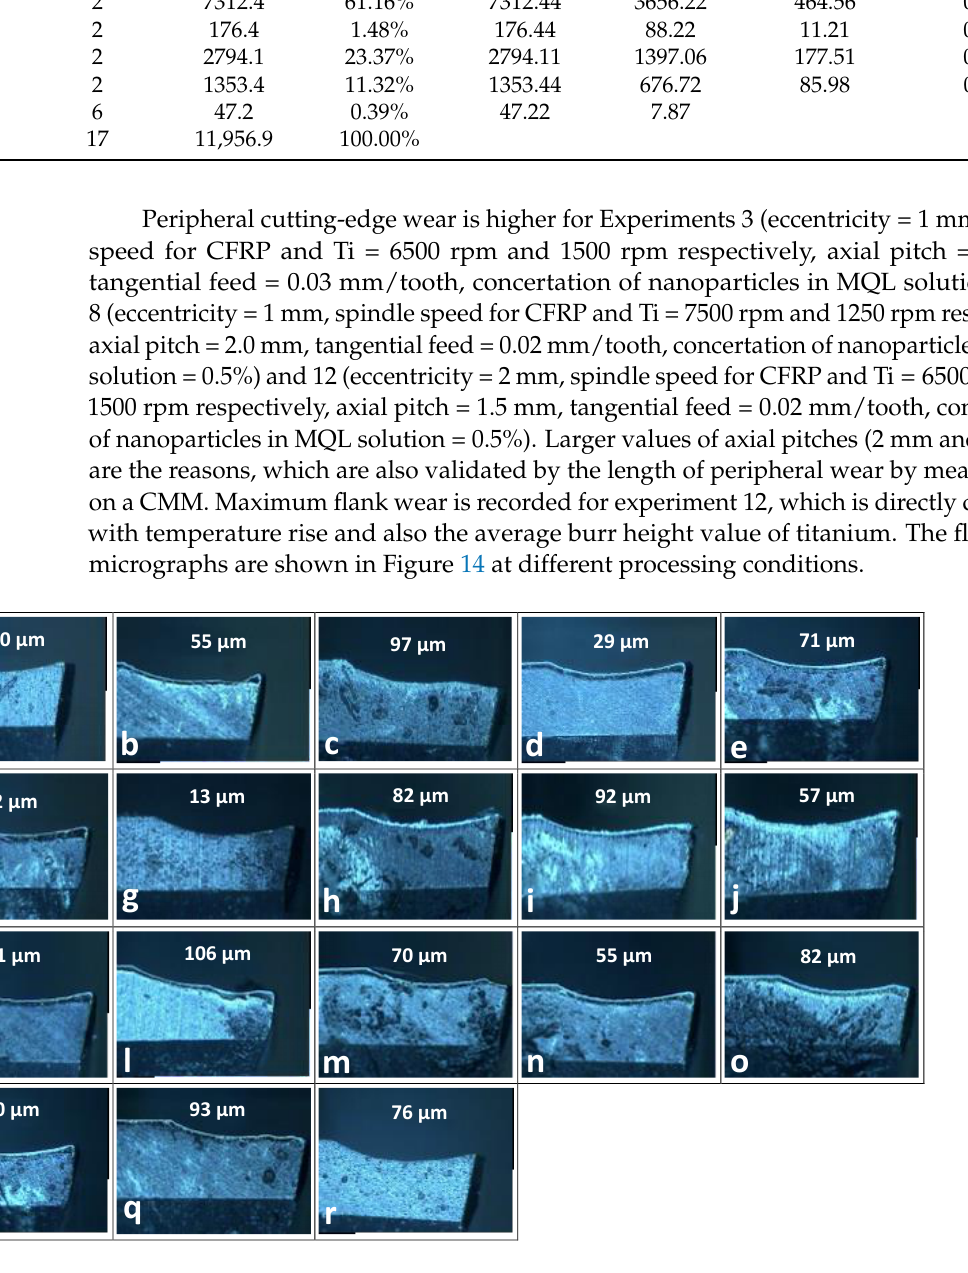
Figure 14. Flank wear over different parametric conditions in the experimental matrix ( a – r ) based on design of experiment settings. Fractography was done using a microscope, which affirms that the prominent frac- ture modes were abrasion wear, plastic deformation, built-up edges, and material adhe- sion, which is also endorsed in the literature [12]. The composition patterns of the worn- out and best tools showed that the worn tool had fewer coating components (firex), which